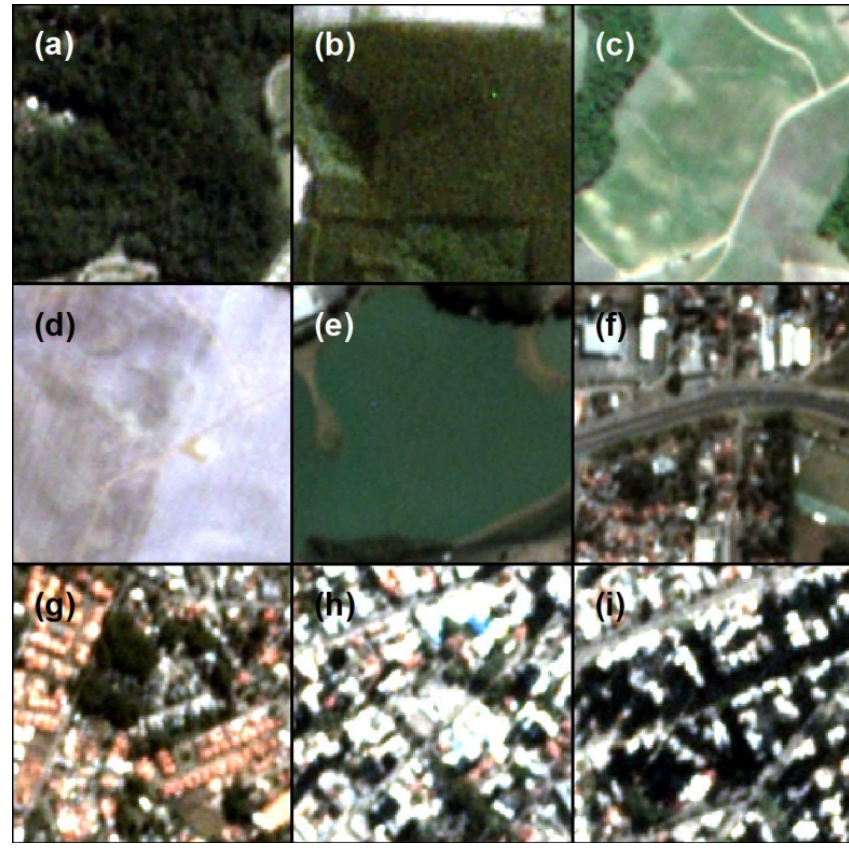
Figure 2. True-color composition image samples of defined classes. ( a ) Arboreal vegetation; ( b ) Silviculture; ( c ) Grass or cultivated areas; ( d ) Bare land; ( e ) Water; ( f ) Paved roads and streets; ( g ) Built-up areas, Type 1; ( h ) Built-up areas, Type 2; and ( i ) Shadow.